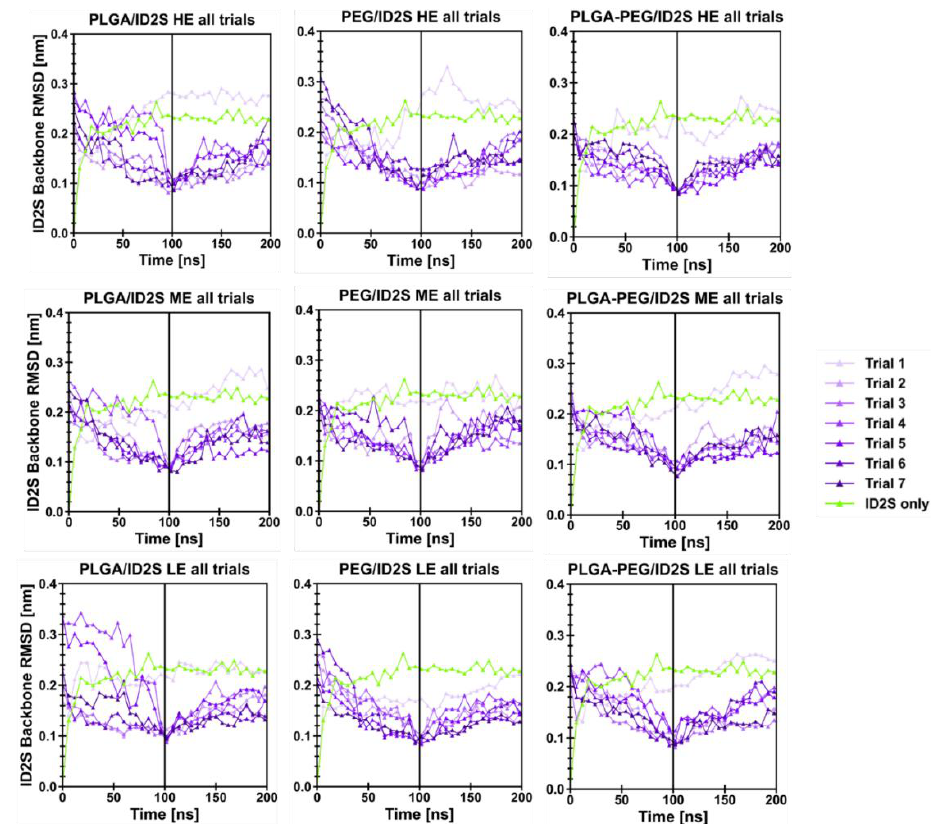
Figure A6. Root-mean-squared deviation (RMSD) of ID2S from its crystal structure versus time is shown for all levels of extension for PLGA/ID2S ( left column), PEG/ID2S ( middle column), and PLGA-PEG/ID2S ( right column). RMSD values were plotted every 6 ns. ID2S in water system served as a control and is shown in green.